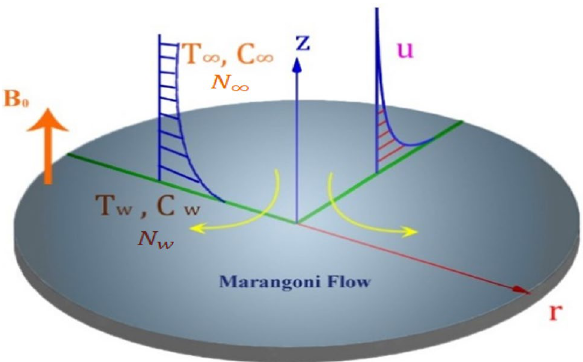
Figure 5. Physical